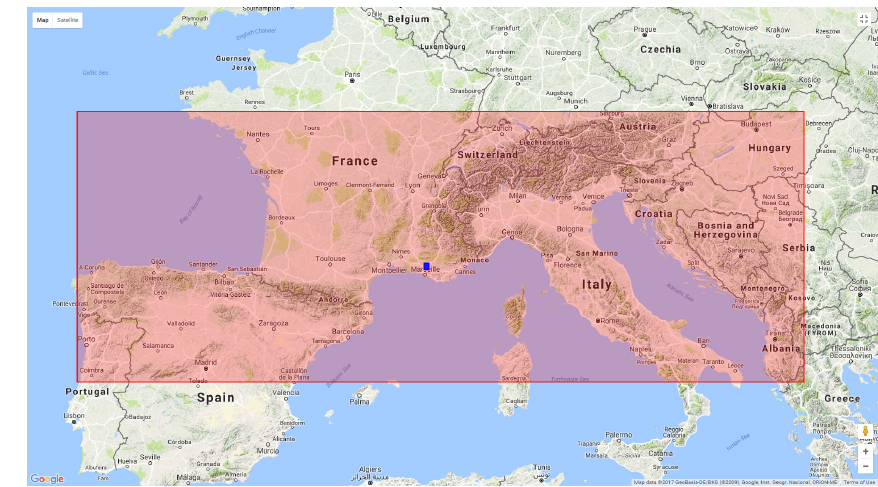
Figure 1. Area defined for coincident measurements 40 ◦ N, 9 ◦ E to 48 ◦ N, 21 ◦ E. L’Observatoire de Haute Provence in blue at 43.93 ◦ N, 5.71 ◦ E (data: Google Maps, 2017).